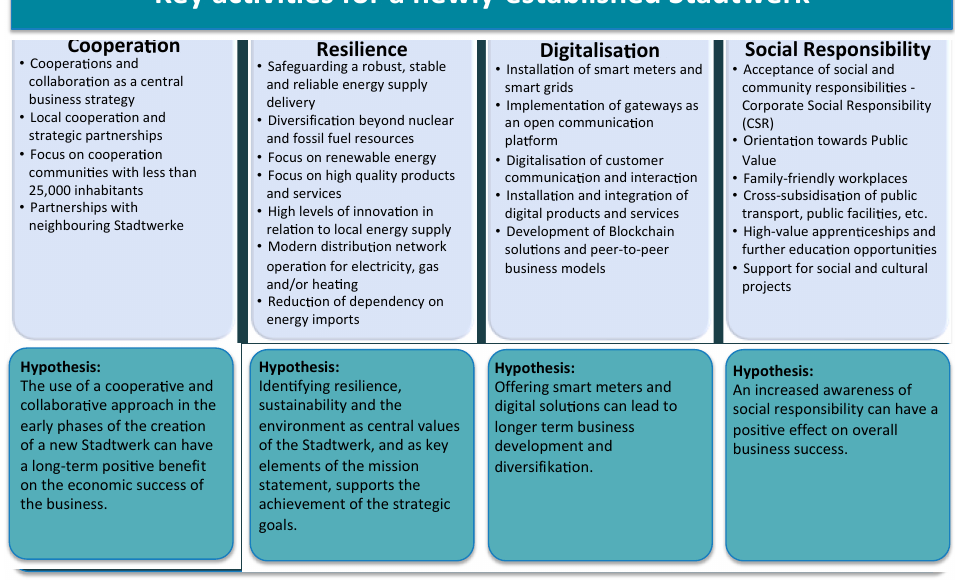
Figure 5. Effective approaches and actions for newly-founded Stadtwerke. The results of our survey suggested that digitalisation was perceived to have a rela- tively low level of importance. This is in part due to the fact that new Stadtwerke were often not active in all elements of the energy supply chain. For example, a smart-grid strategy is not important for a Stadtwerk that is not a grid